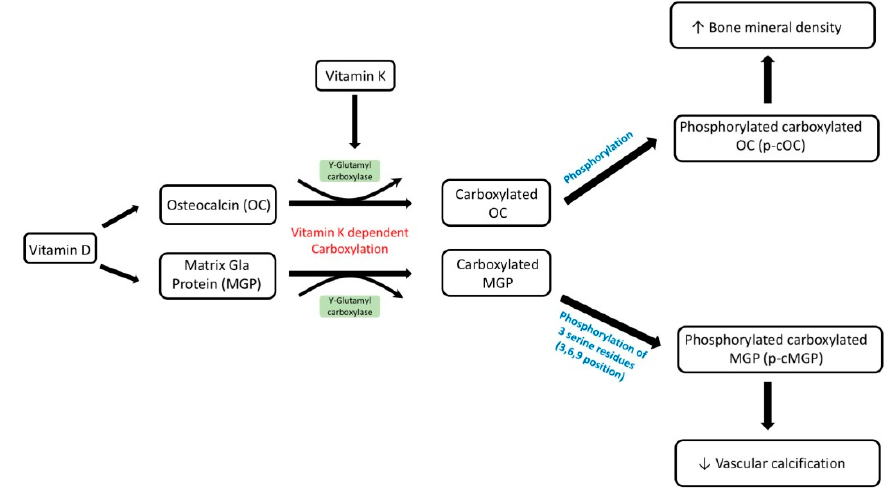
Figure 3. Synergistic effect of vitamins D and K on bone and vascular calcification. Vitamin D has been demonstrated to interact with vitamin K-dependent protein (VKDPs). VKDPs include several clotting factors and bone and soft tissue mineralization proteins, such as osteocalcin (OC) and matrix Gla protein (MGP). OC is carboxylated by vitamin K, and carboxylated OC is produced by osteoblasts. Carboxylated OC binds to hydroxyapatite in the extracellular matrix fob one. MGP is found mainly in normal vascular smooth muscular cells and upregulated during calcification. Vitamin D supplementation is beneficial for OC and MGP carboxylation and is further phosphorylated to the phosphorylated carboxylated product (p-c OC and p-c MGP), which can further improve bone mineralization and alleviate vascular calcification in CKD patients.